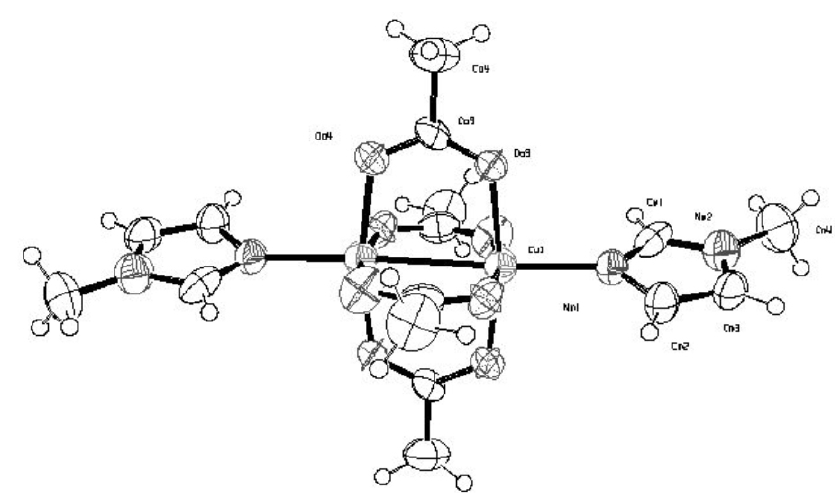
Figure 3. ORTEP plot of the crystal structure of 3 [Cu(N-Methylimidazole)(OOCCH